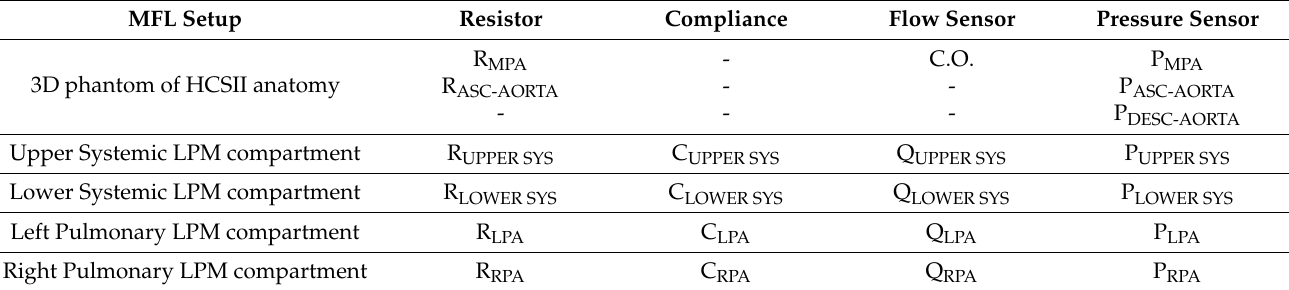
Table A2. Nomenclature and location of LPM elements for each compartment.